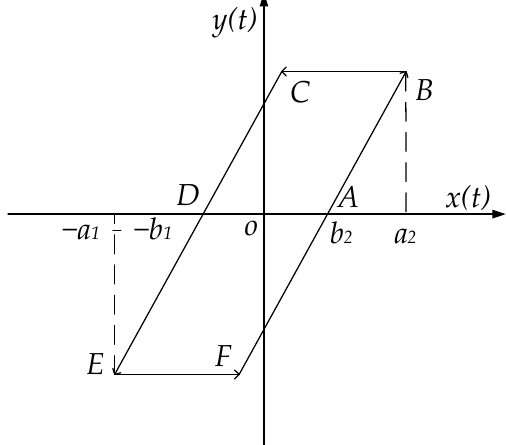
Figure 2. Clearance nonlinear hysteresis model.